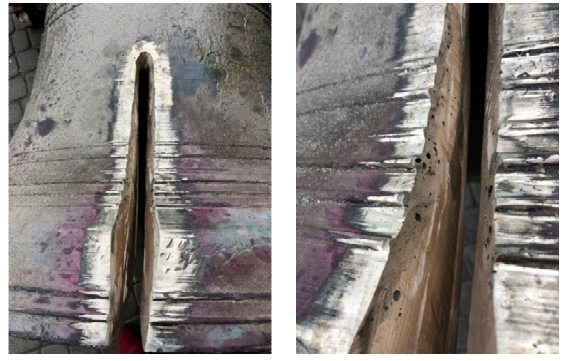
Figure 6. Mechanical treatment of the damaged place.